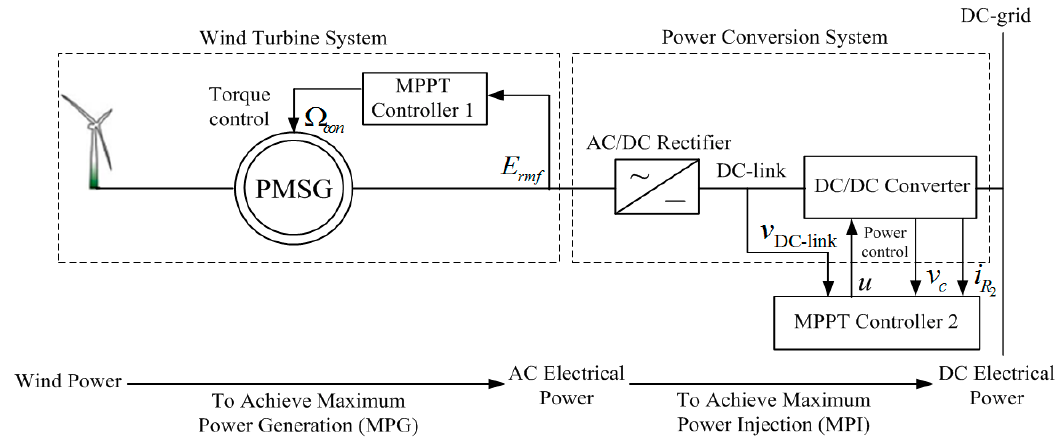
Figure 1. Schematic diagram of a low-power wind energy conversion (WEC) system in a DC microgrid.